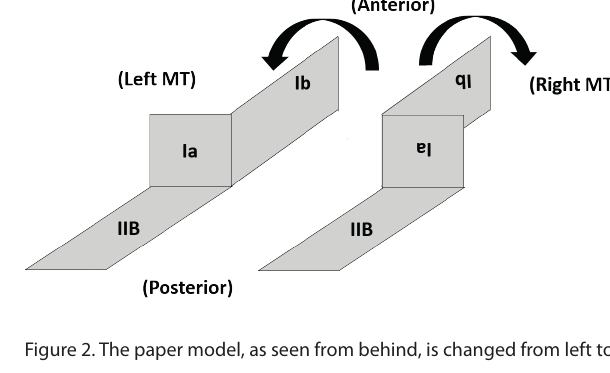
Figure 2. The paper model, as seen from behind, is changed from left to right design and vice versa by rotating only the first piece of paper (Ia & Ib) 180 o anticlockwise and clockwise, respectively.